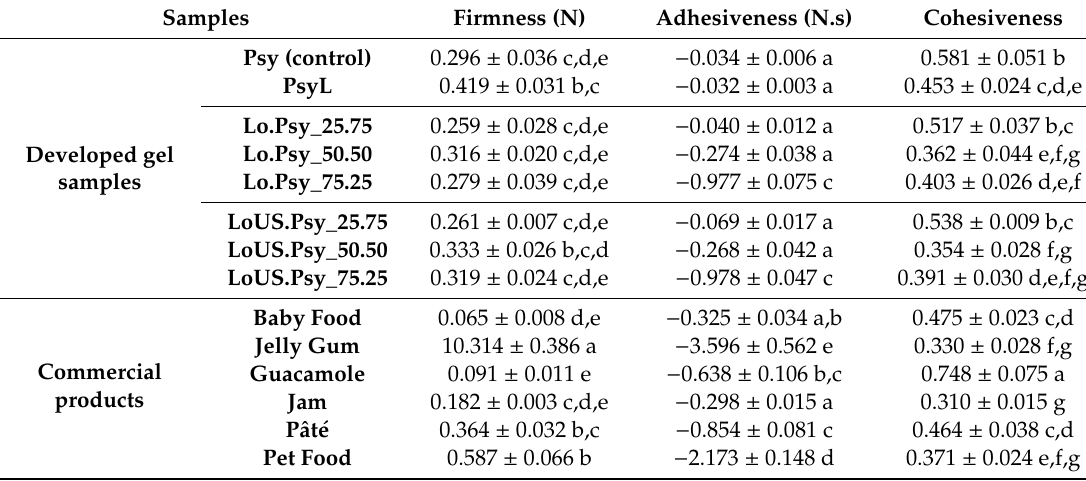
Table 4. Texture parameters (firmness, adhesiveness and cohesiveness) of the gels developed and commercial